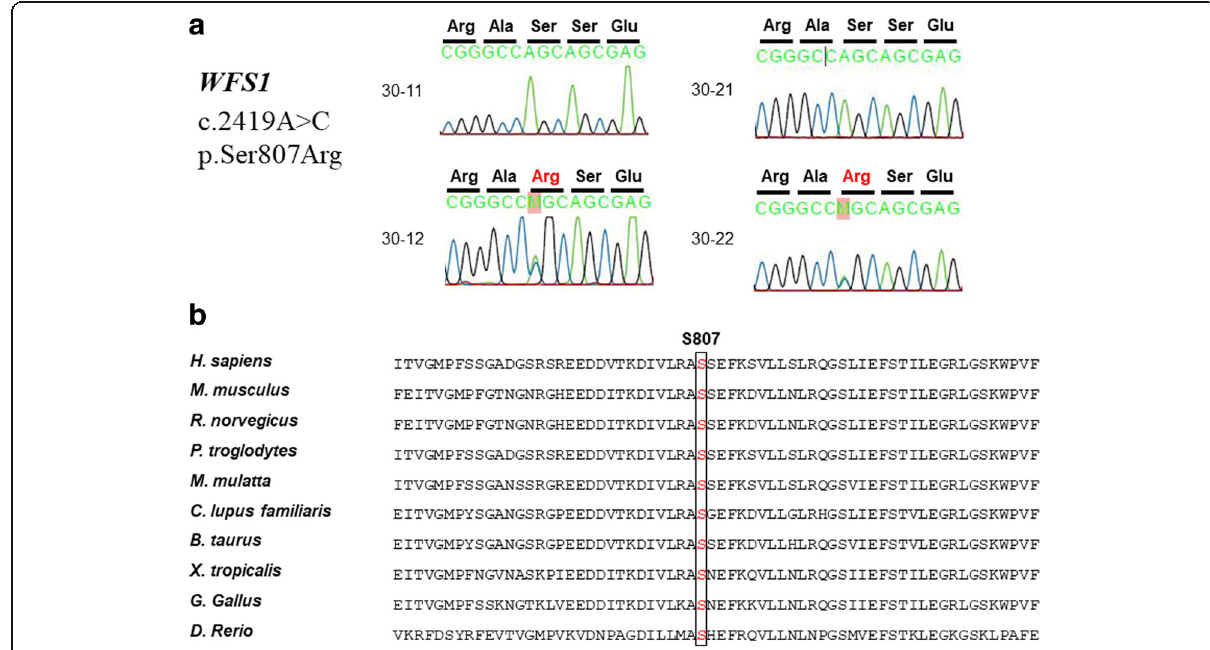
Fig. 2 A mutation in WFS1 identified using whole-exome sequencing. a Sanger sequencing traces of subjects 30 – 11, 30 – 12, 30 – 21, and 30 – 22. b Mul- tiple sequence alignment of WFS1 among different species. p.S807 is well preserved among various